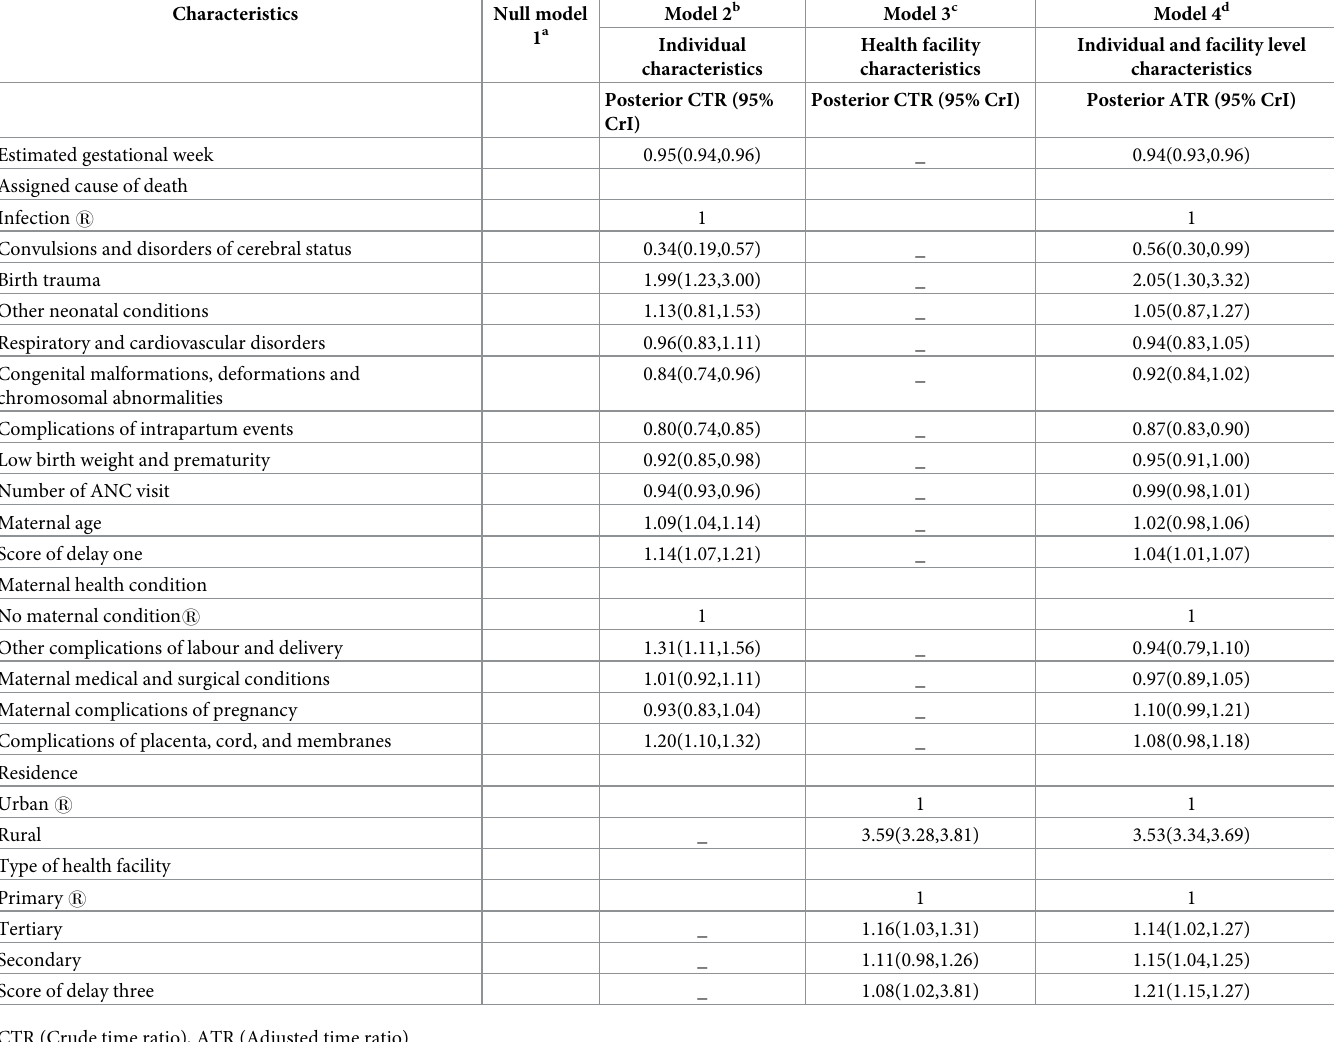
Table 9. Bivariable and multivariable Bayesian multilevel parametric survival model on predictors of days of early neonatal death in Ethiopia,2021.